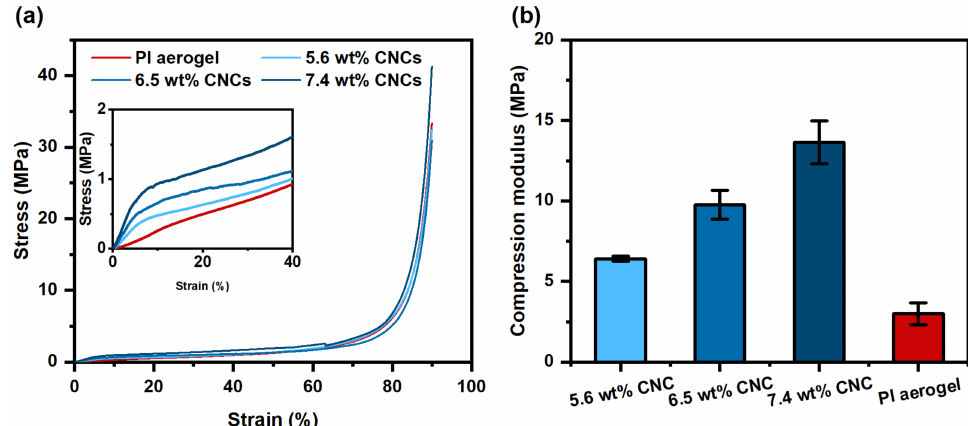
Figure 7. Mechanical properties of the aerogels using different concentrations of CNCs. ( a ) Compres- sive stress–strain curves. ( b ) Comparison of compressive